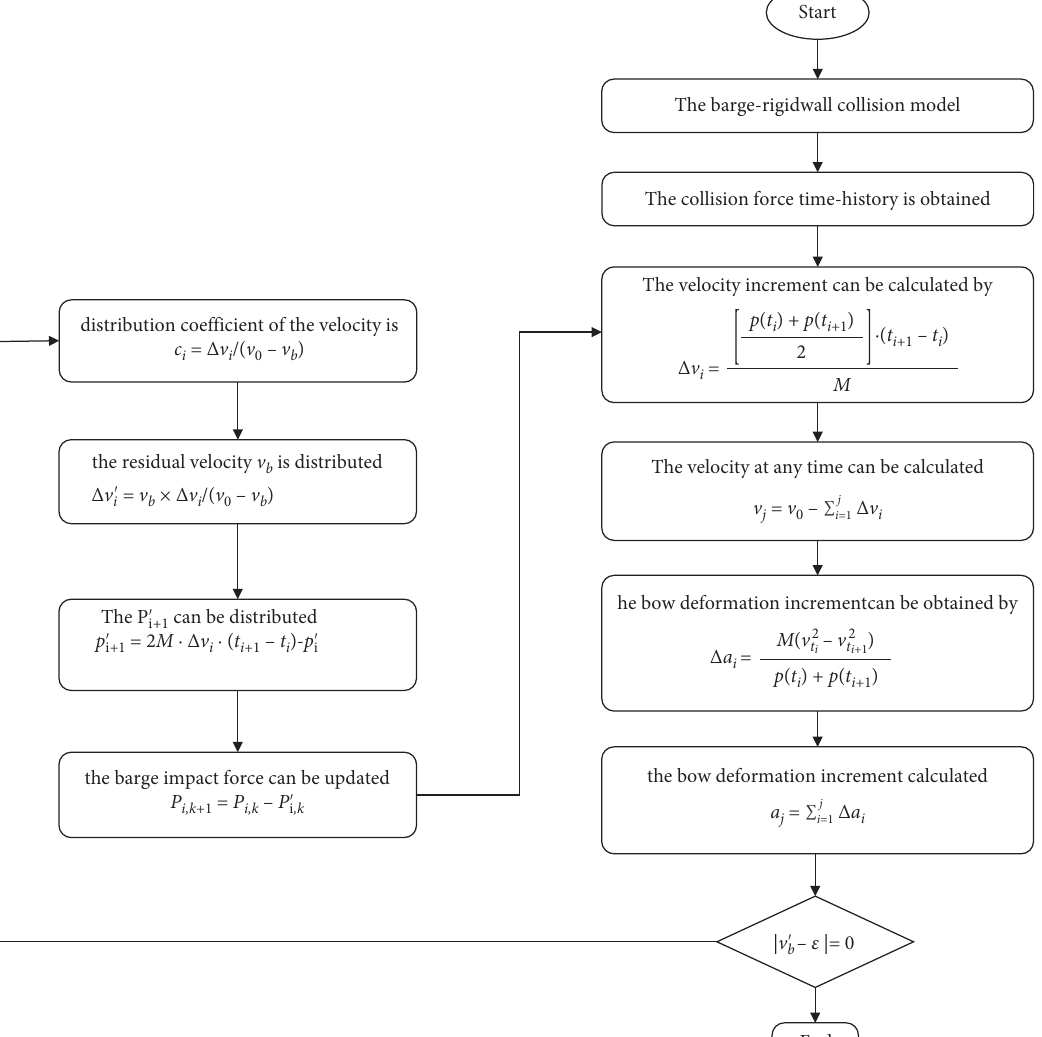
Figure 2: The flow chart of NSS